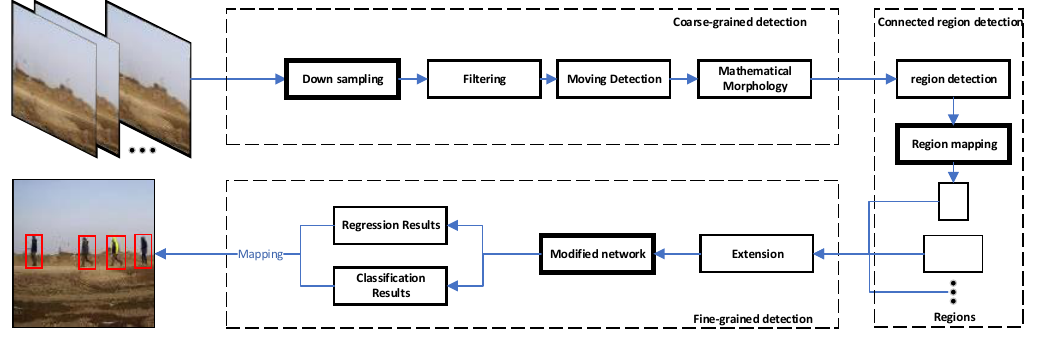
Figure 1. Developed a modified moving object detection framework.